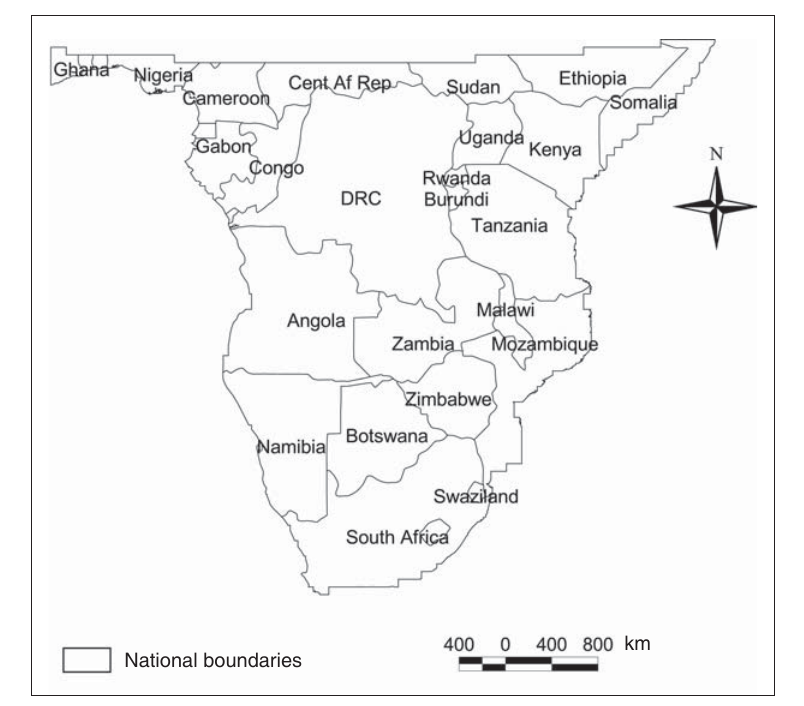
FIG. 1 Study area